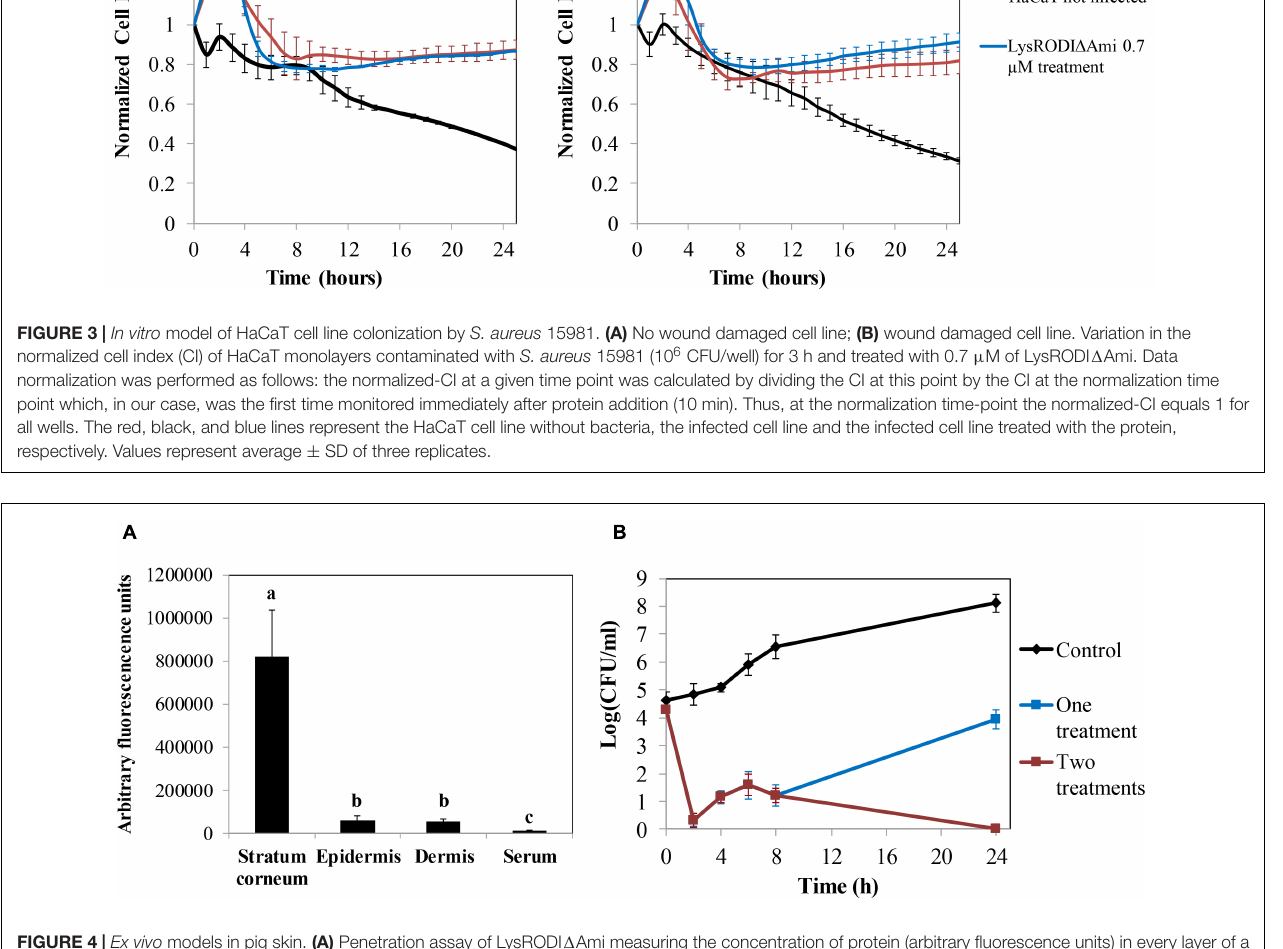
FIGURE 4 | Ex vivo models in pig skin. (A) Penetration assay of LysRODI (cid:49) Ami measuring the concentration of protein (arbitrary fluorescence units) in every layer of a pig skin explant. Bars represent means ± SDs of three replicates. Bars having distinct lower case letters are statistically different ( p < 0.05) according to the ANOVA and SLK post hoc comparison test. (B) Activity of LysRODI (cid:49) Ami against S. aureus 15981 in an ex vivo pig skin disinfection model. Data represent log(CFU/ml) for each explant after treatment with either a single dose of the lead variant (16.5 µ g/cm 2 ) or two doses of the protein (the second dose was administered 8 h after the first dose). The control represents the bacterial number without protein treatment. Values correspond to the mean ± SD of four replicates. The bacterial detection limit is 5 CFU per